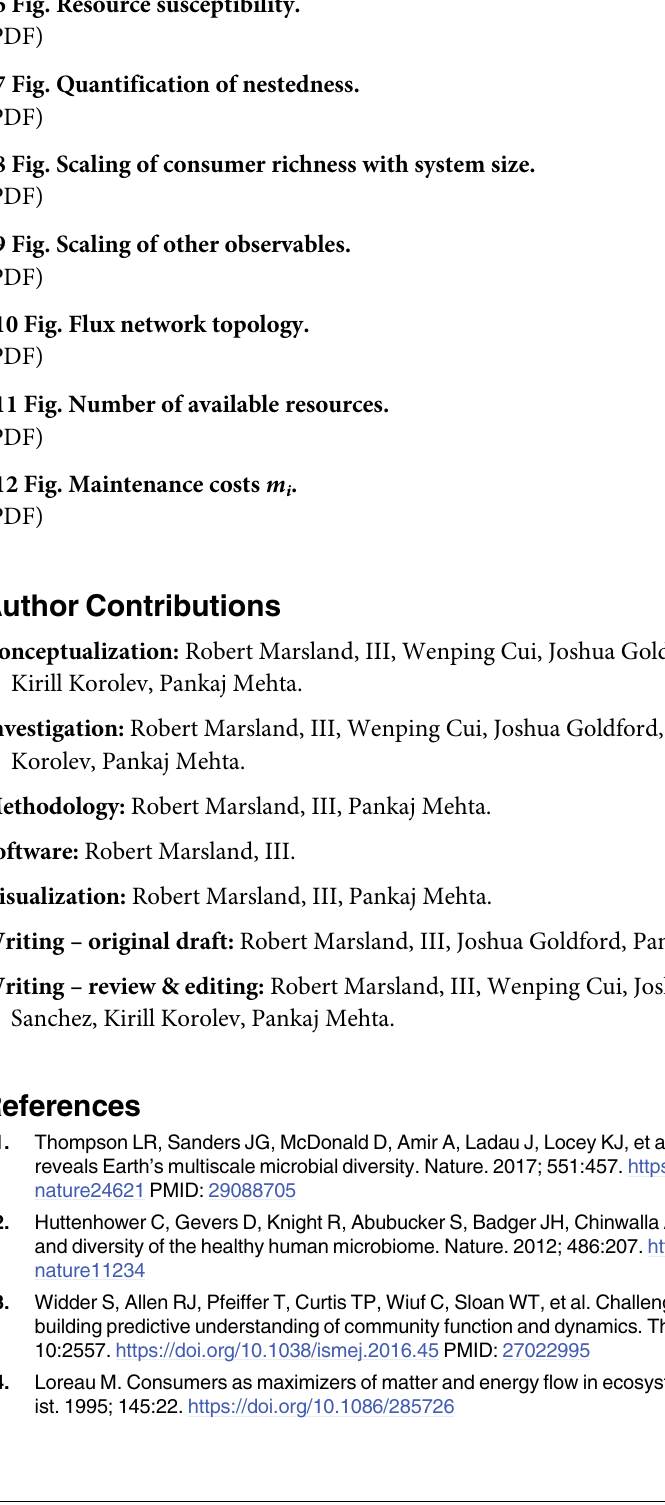
S4 Fig. Rank-abundance curves for three representative examples. (PDF) S5 Fig. Effective number of resources consumed under different modeling choices. (PDF) S6 Fig. Resource susceptibility. (PDF) S7 Fig. Quantification of nestedness. (PDF) S8 Fig. Scaling of consumer richness with system size. (PDF) S9 Fig. Scaling of other observables. (PDF) S10 Fig. Flux network topology. (PDF) S11 Fig. Number of available resources. (PDF) S12 Fig. Maintenance costs m